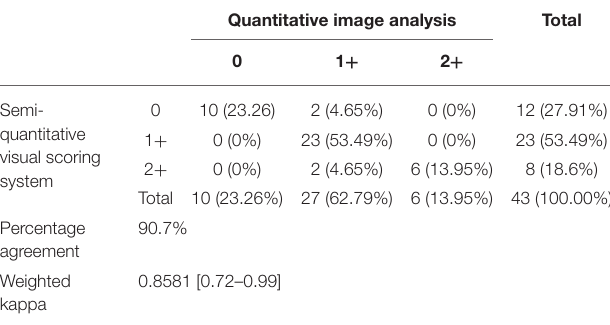
TABLE 2 | Frequency of agreement between visual scoring and